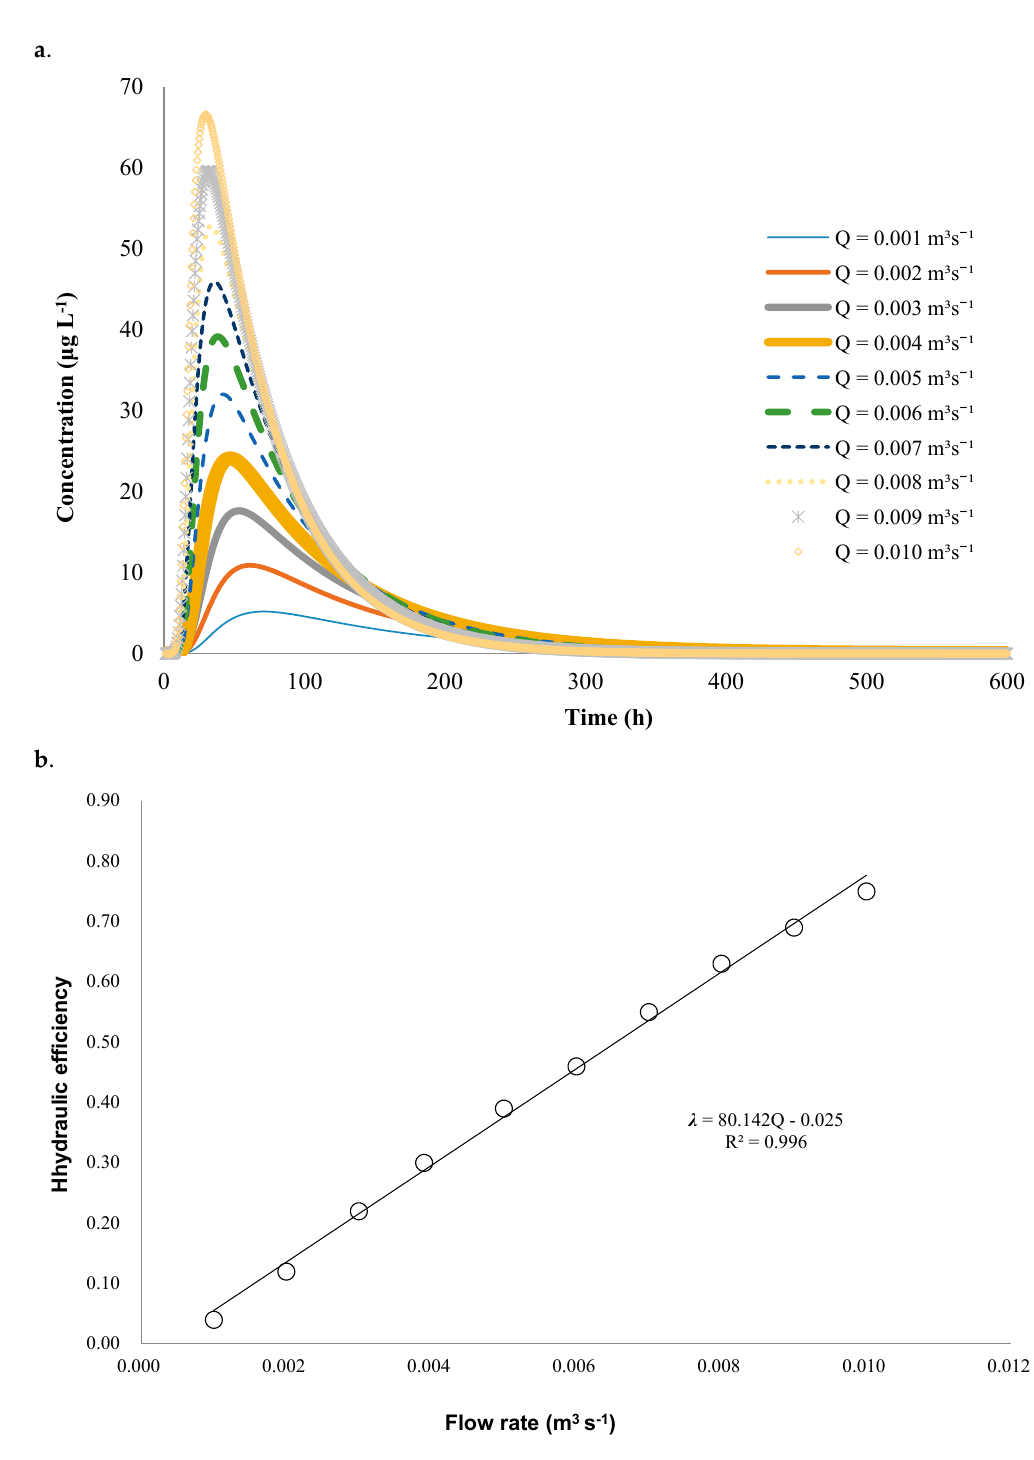
Figure 4. ( a ) Tracer concentration hydrograph and ( b ) hydraulic efficiency at the pond outlet across the entire pond for different flow rates.